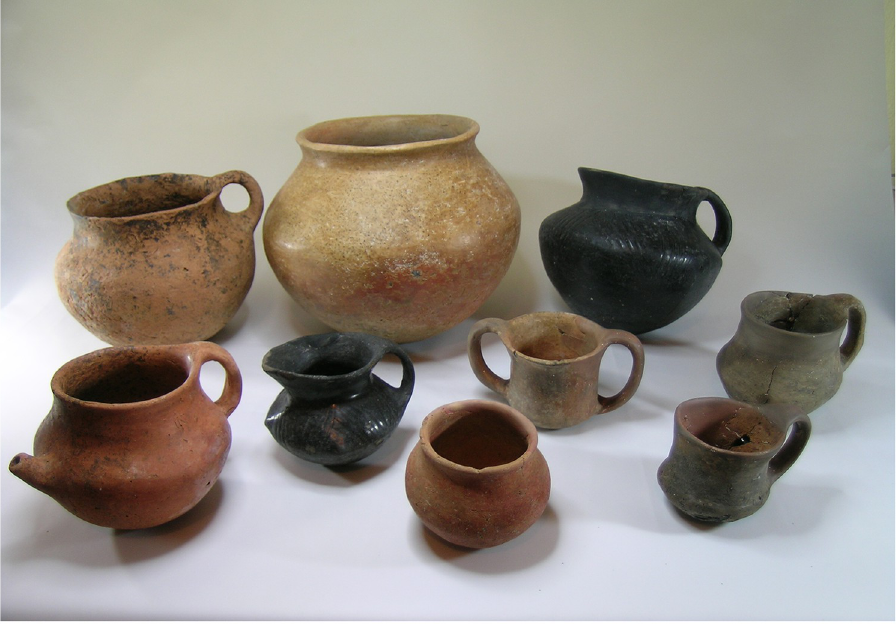
Fig 3. Examples from the local 3 rd millennium BC ceramics from Resulo ğ lu ( © Resulo ğ luexcavations archive).